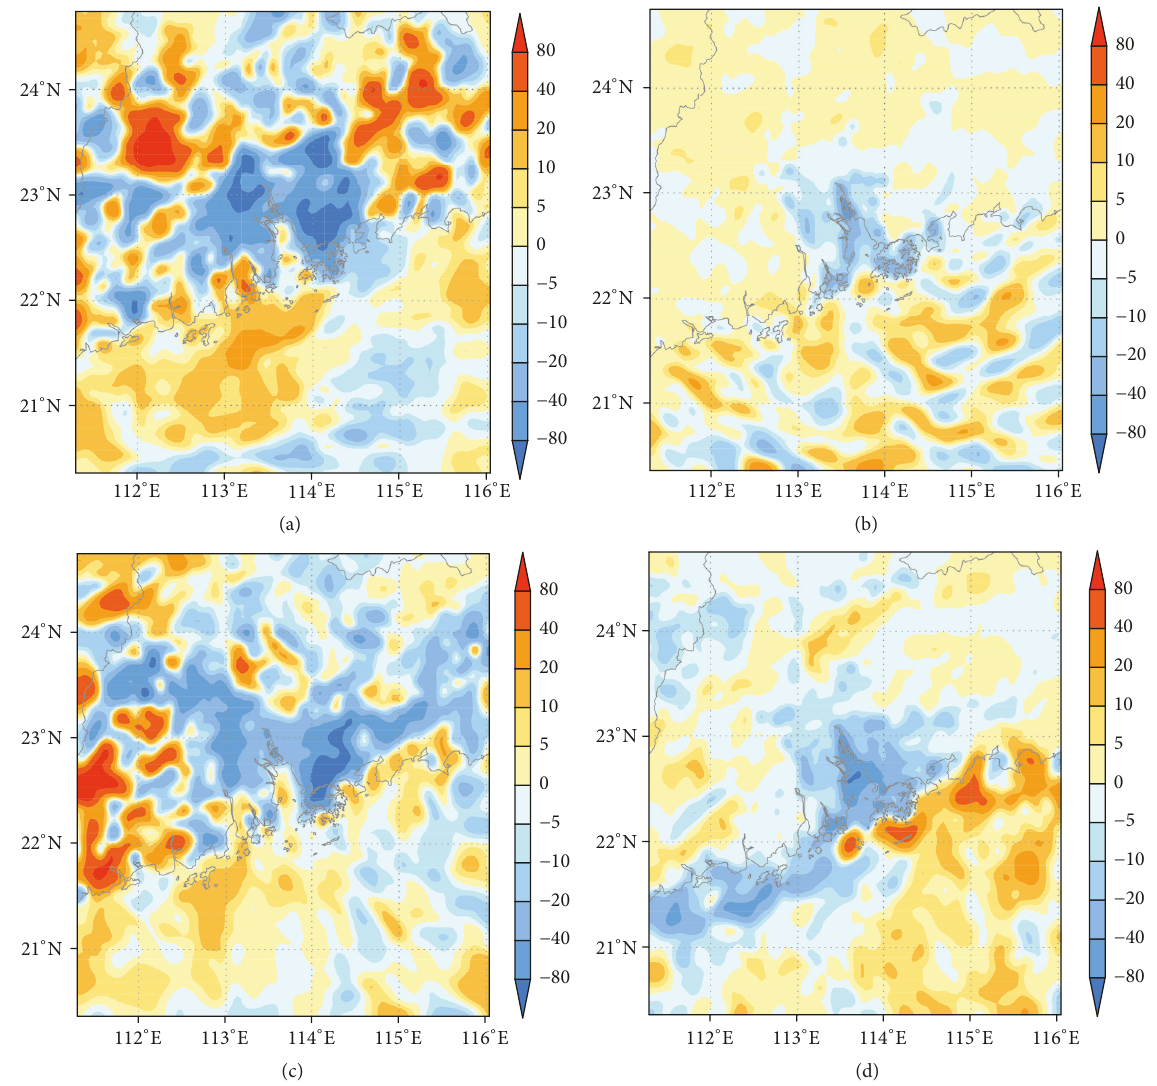
Figure 7: As in Figure 6, but for ground upward 1-h accumulated latent heat fluxes (unit: Wm −2